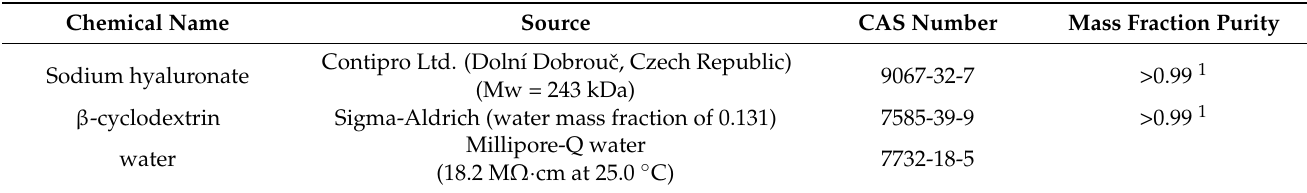
Table 3. Reagents used in the